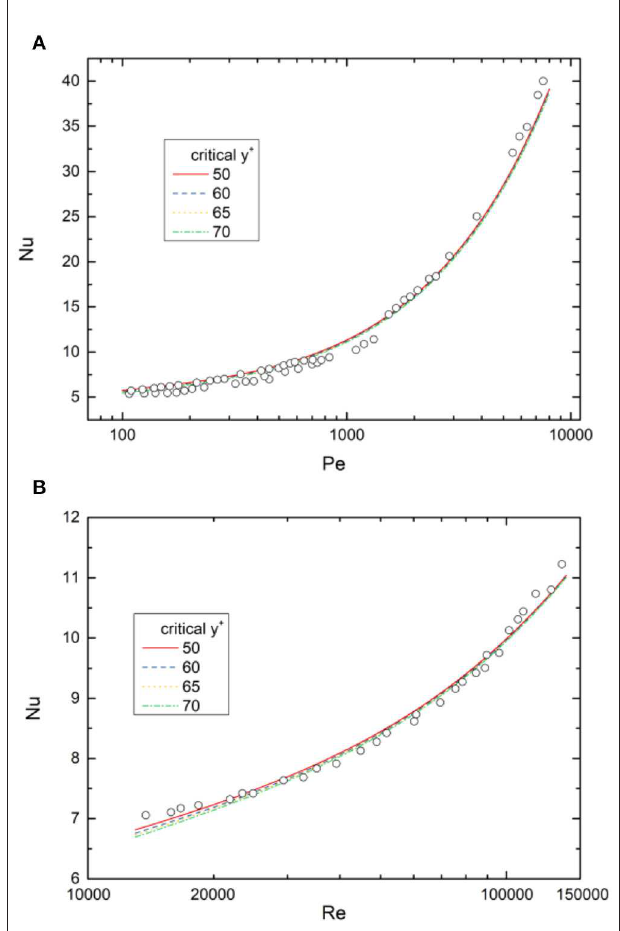
FIGURE 4 | Effects of y + crit on prediction of Nusselt number. (A) Nusselt vs. Peclet number. (B) Nusselt vs. Reynolds